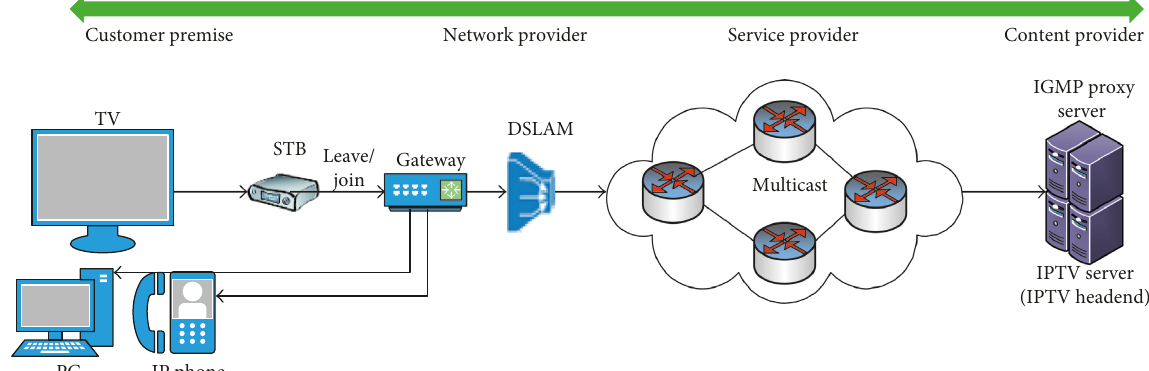
Figure 1: IPTV architecture over a converged